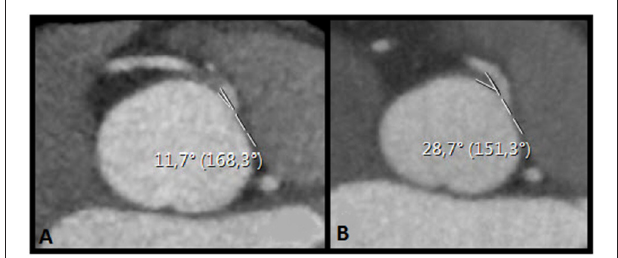
FIGURE 1 | Take-off angles preoperatively (A) and postoperatively (B) obtained in multiplanar reconstructions in the oblique view at the level of the AAOCA ostium, in the same patient. The angle increased from 11.7 to 28.7 ◦ .